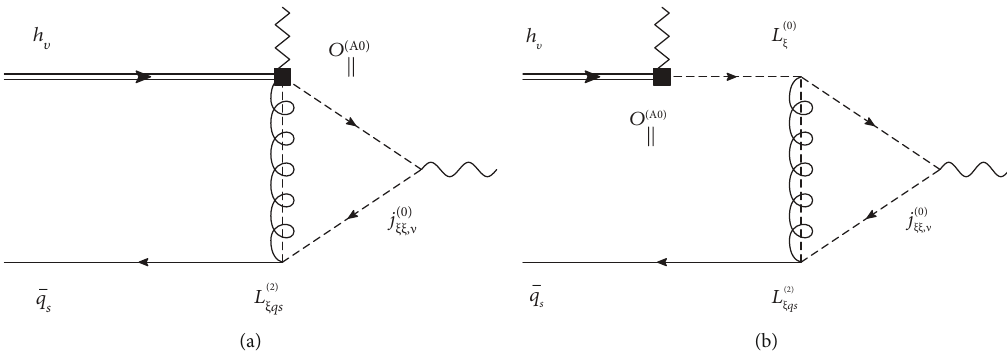
Figure 4: Diagrammatic representation of the vacuum-to- B -meson correlation function Π B (cid:1) ξ Þ γ , the leading power interpolating current j ð 0 Þ ξξ O ð A 0 Þ ∥ = ð W h c v 5